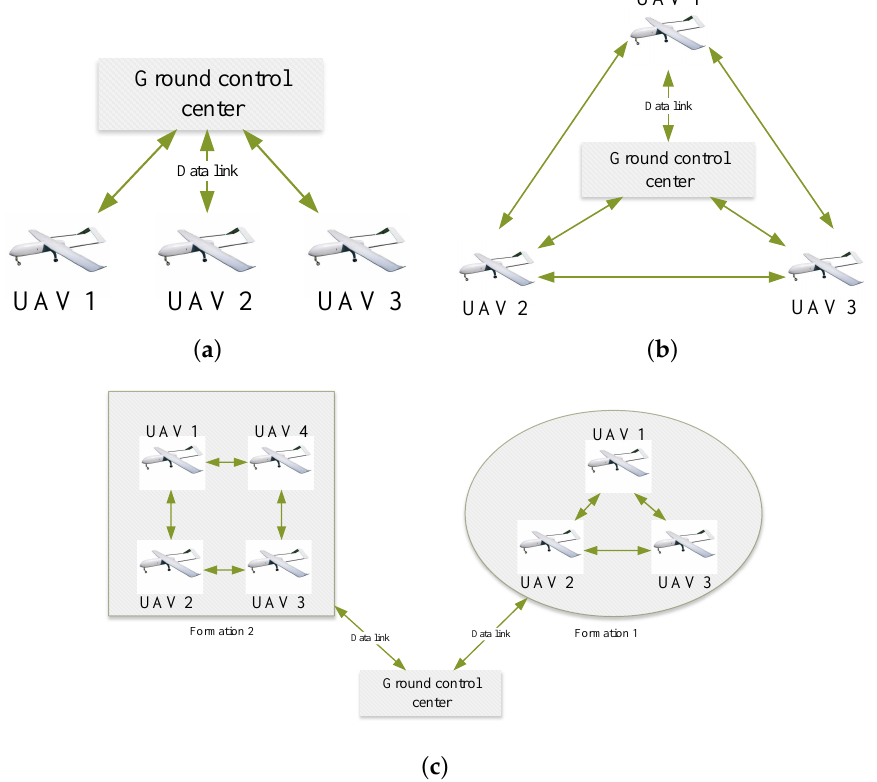
Figure 3. Three typical formation architectures. ( a ) Centralized architecture; ( b ) distributed architec- ture; ( c ) mixed